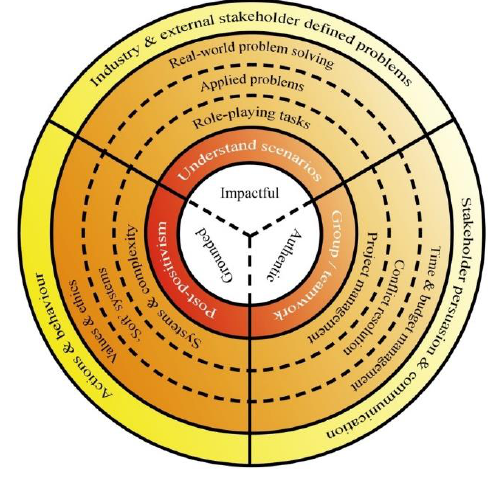
Figure 15. Summary of sustainability education principles and progression.